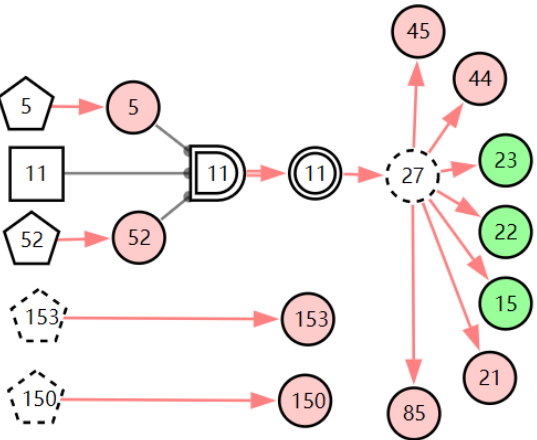
Figure 10. The graphic interpretation of chronic laryngitis when E ’ = X X 44,1 X 150,1 X 5,1 X 153,1 .